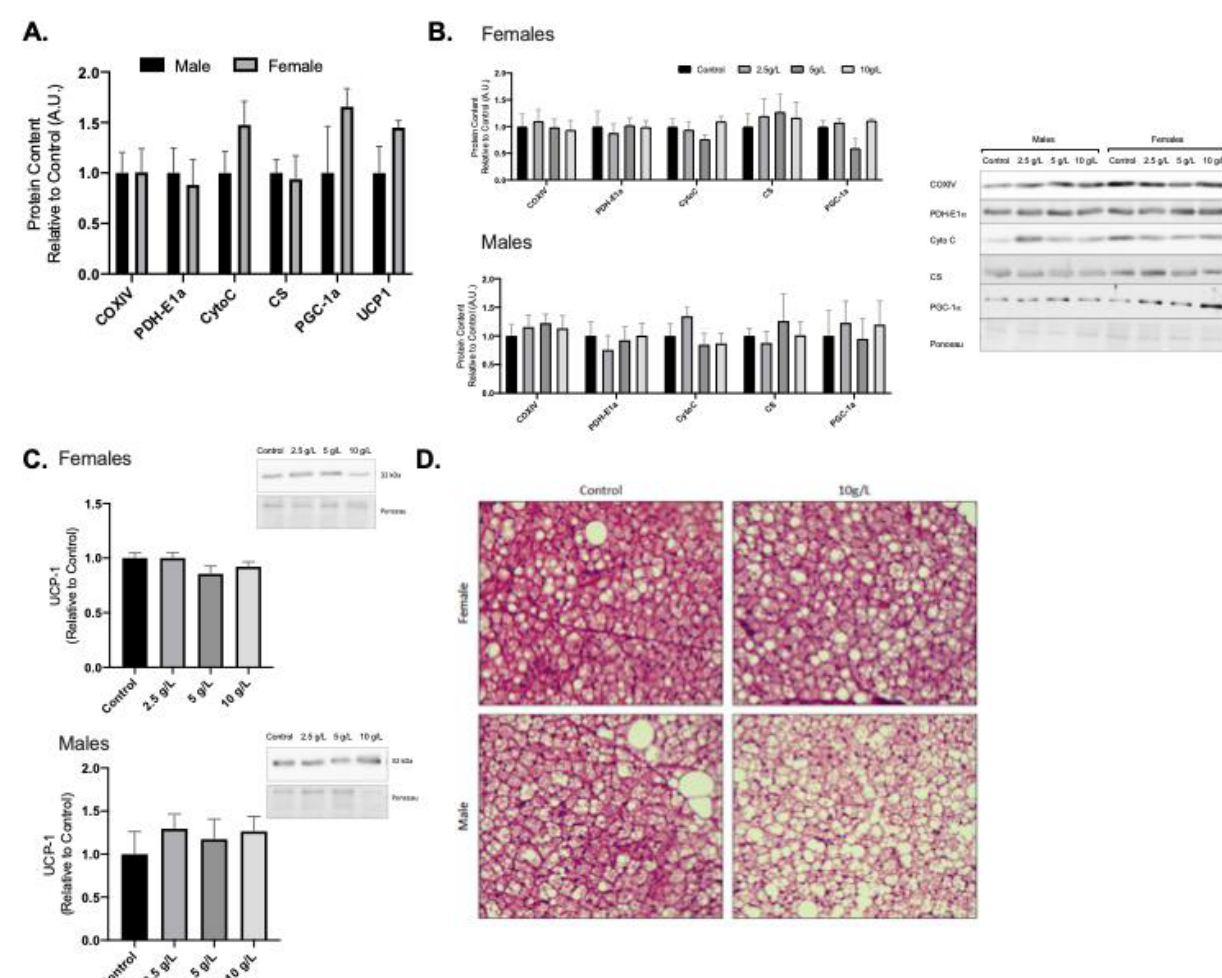
Figure 3. Brown adipose tissue (BAT) mitochondrial protein content and morphology. ( A ) Quantified Western blot data for BAT protein content of COXIV, PDH-E1 α , Cytochrome C (Cyto C), citrate synthase (CS), PGC-1 α , and uncoupling protein-1 (UCP1) for control male and female rats. ( B ) Quantified Western blot data for mitochondrial proteins across creatine supplemented groups and representative Western blot images. ( C ) UCP-1 content in male and female rats across creatine supplemented groups. ( D ) Representative images of H&E stained slides. Scale bar on H&E representative image represents 100 μm. Data were analyzed by ANOVA and are presented as mean ± SEM, * denotes significantly different from control group, p < 0.05.